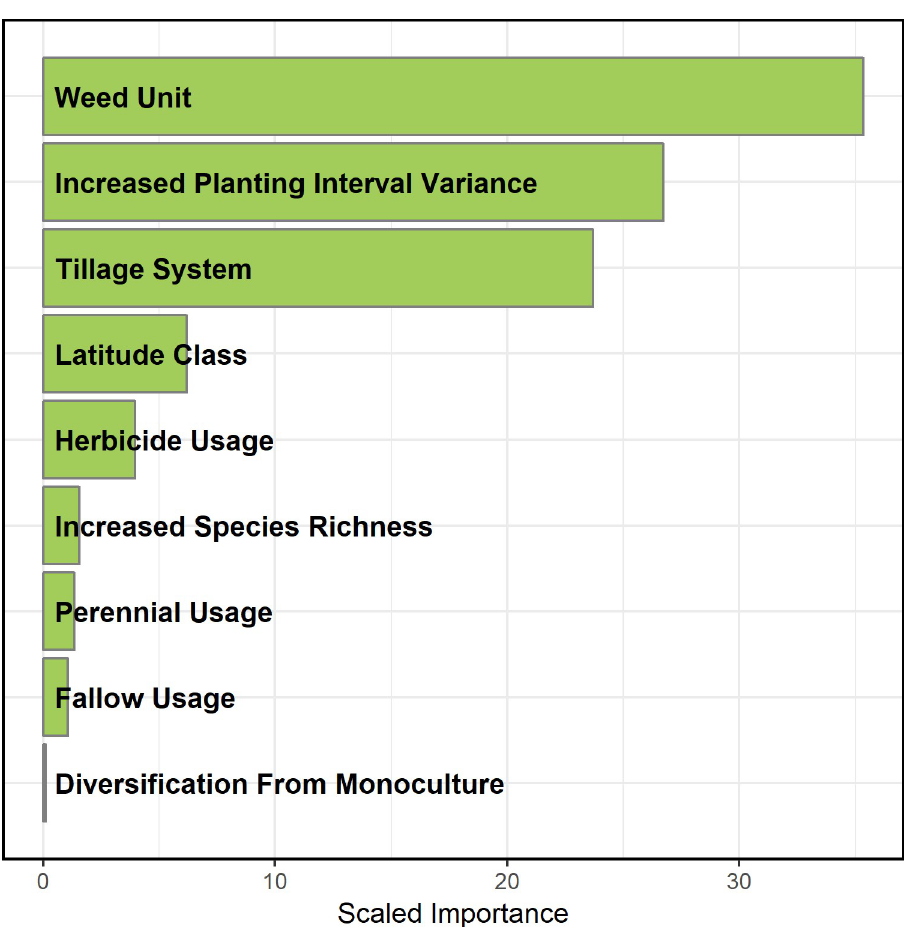
Fig 4. Scaled importance of nine predictors for weed density response to increased rotational diversity. Variable importance derived from a generalized boosted regression tree.